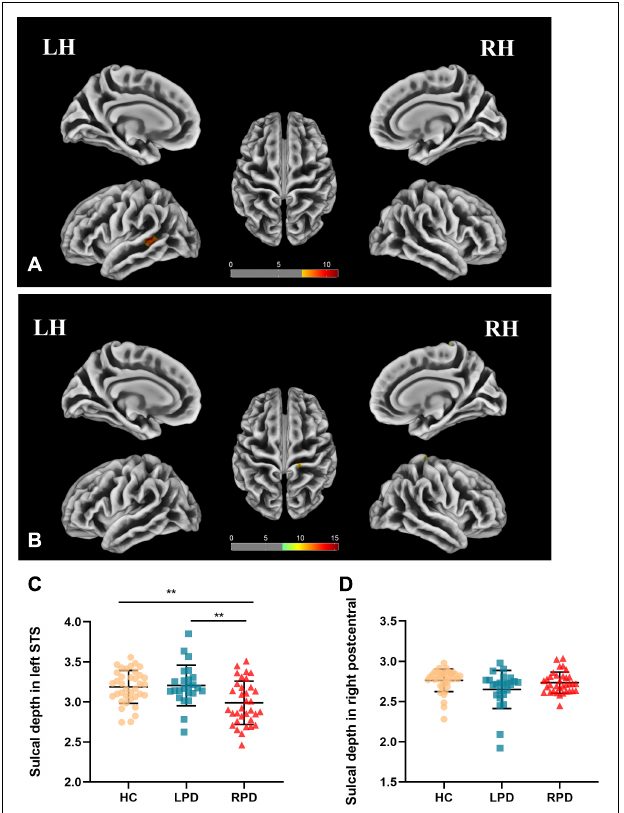
FIGURE 2 | (A,B) Sulcal depth analysis of the group effect is highlighted ( p < 0.05, FWE correction). (C,D) Boxplots of the distribution of sulcal depth in the banks of left STS and postcentral of the right hemisphere among the three groups ( post hoc p < 0.017, Bonferroni corrected). Post hoc analyses revealed significantly decreased sulcal depth in the banks of left superior temporal of patients with RPD compared with HC (** p = 0.003) and LPD (** p = 0.004).